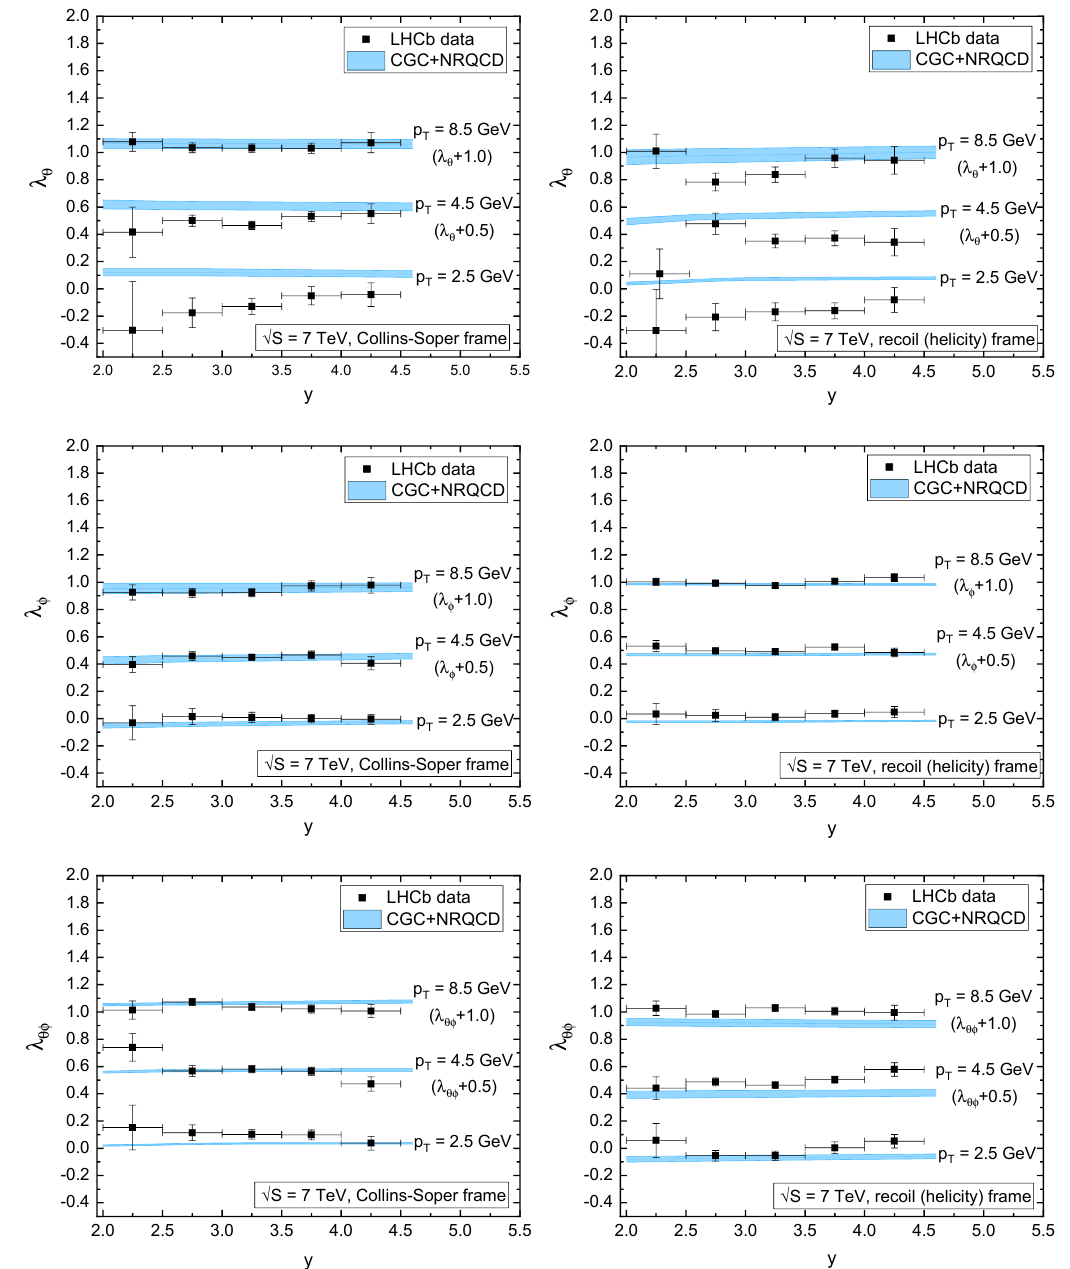
Figure 4 . The angular coe(cid:14)cients (cid:21) (cid:18) ((cid:12)rst row), (cid:21) (cid:30) (second row) and (cid:21) (cid:18)(cid:30) (third row) in the Collins-Soper frame (left column) and recoil frame (right column) as functions of the J= ’s rapidity y , plotted for three transverse momentum values p T = 2 : 5 ; 4 : 5 ; 8 : 5 GeV. Some values of (cid:21) were shifted for better visibility: by 0.5 for p T = 4 : 5 GeV and by 1.0 for p T = 8 : 5 GeV. Data are from the LHCb experiment at 7 TeV